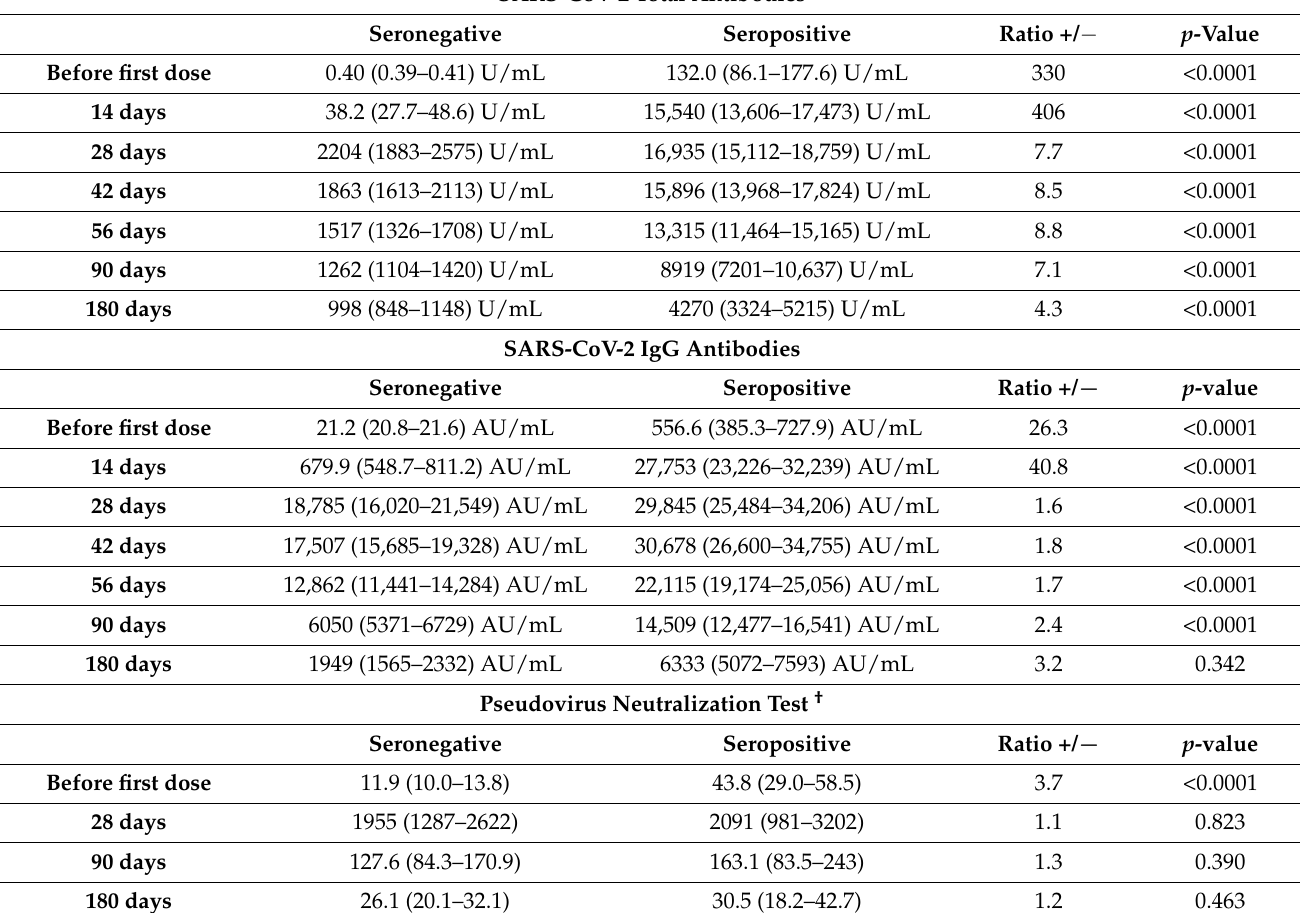
Table 1. Evolution of SARS-CoV-2 spike antibodies (U/mL) in seronegative and seropositive persons using the Roche Elecsys ® , the Abbott Architect ® assays and the pseudovirus neutralizing test. Means with 95% confidence intervals are reported. The between group difference of antibody titers were tested using a Tukey multiple comparison test. A multiple testing correction was applied in the multiple group comparison. p -value < 0.05 was considered significant. † pVNT have only been performed in 60